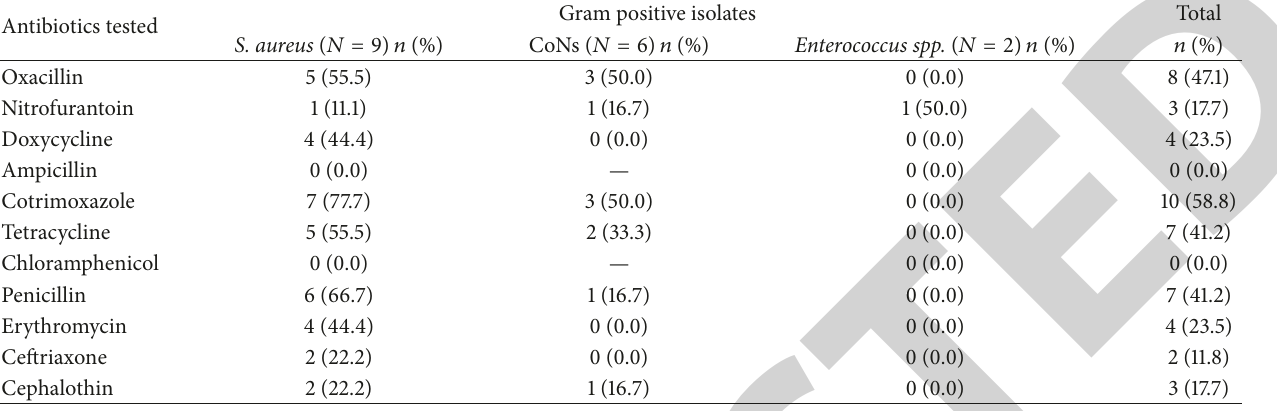
Table 6: Antimicrobial resistance pattern of gram-positive bacteria isolated from urine of diabetic and nondiabetic patients attending Debre Tabor Hospital, Northwest Ethiopia, 2015.